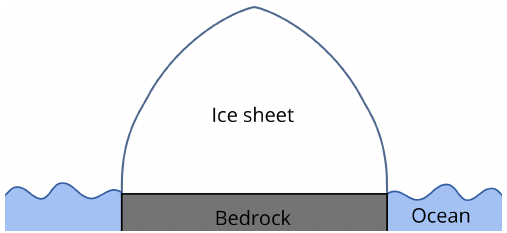
Figure 1. Sketch of the flow-line setup. The ice is sitting on a flat bed; the fixed calving front does not allow ice shelves. The accu- mulation rate is constant throughout the simulation domain, and the temperature is altitude